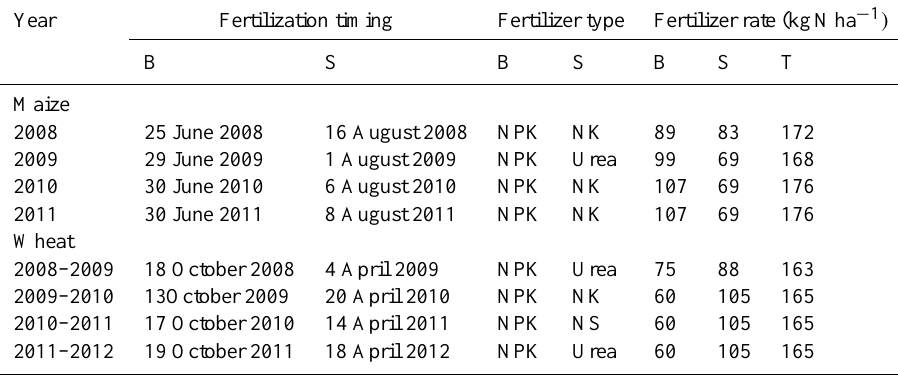
Table 1. The amount, date and type of nitrogen fertilizer application in the experiment